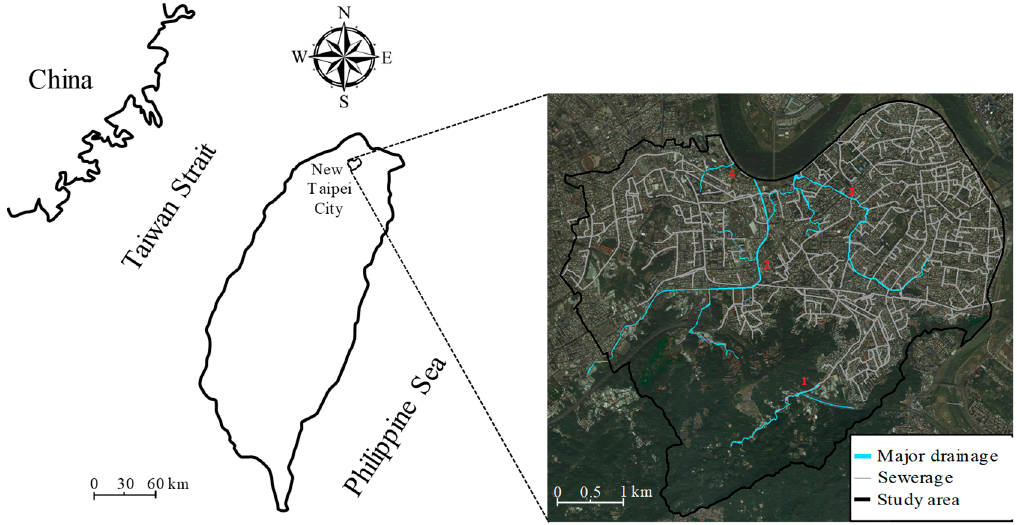
Figure 1. Study region and the drainage system.